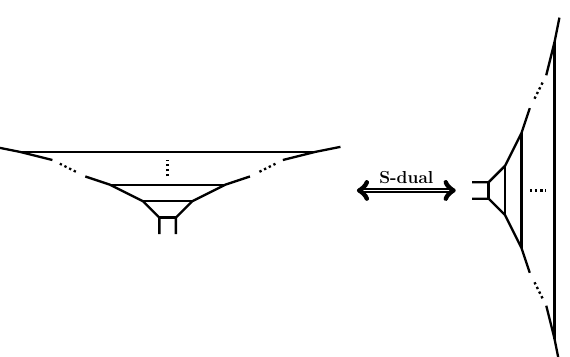
Figure 1 . Left: the 5-brane web for the pure SU( p ) gauge theory with the p D5-branes which lie in the horizontal direction. The parallel two external NS5-branes imply the non-perturbative SU(2) (cid:13)avor symmetry. Right: the S-dual con(cid:12)guration to the 5-brane web on the left. Namely the 5-brane web for the b D p (SU(2))